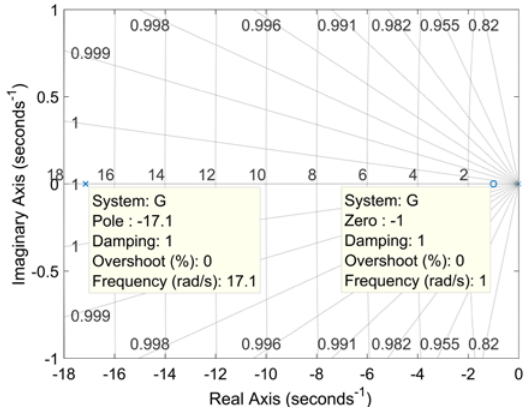
Fig. 6. Pole-Zero map of the plant and controller open loop transfer